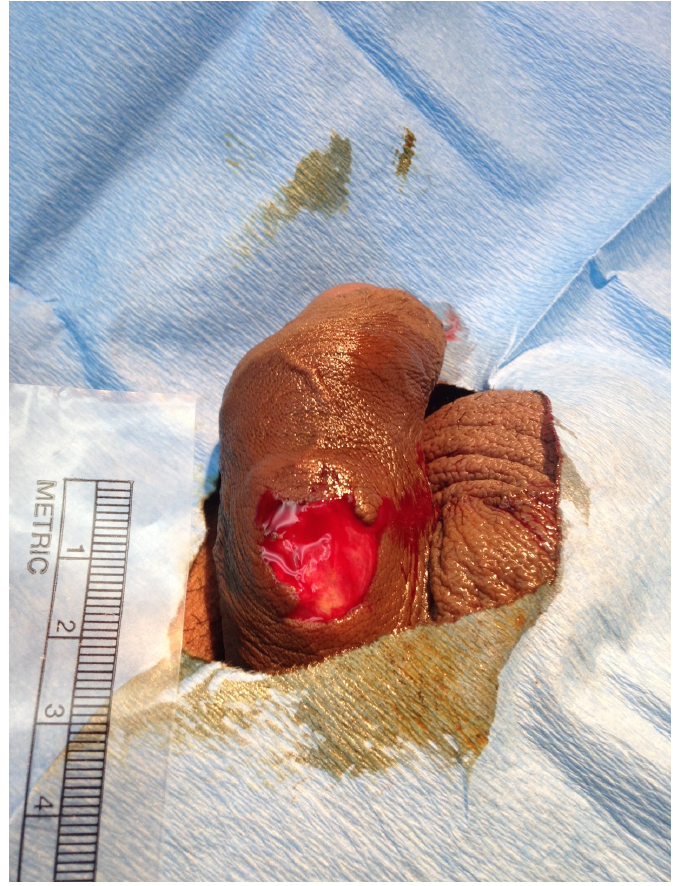
Figure. Penile foreskin avulsion from parrot fish